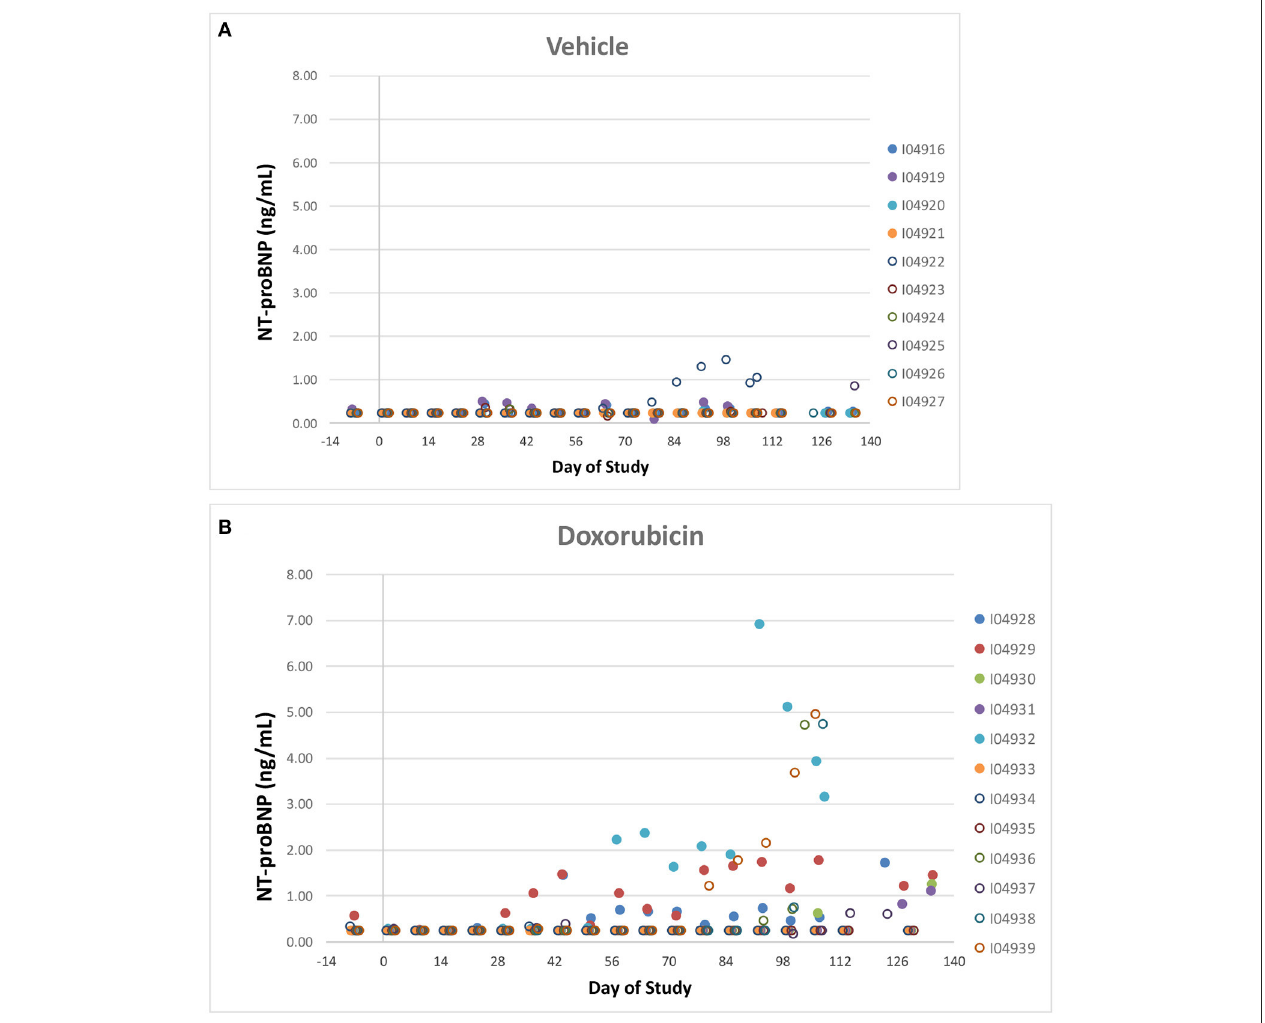
FIGURE 7 | NT-proBNP. Individual animal NT-proBNP measurements in control (A) a treated (B) animals over the course of the study. Filled markers denote animals equipped with LVP catheters.